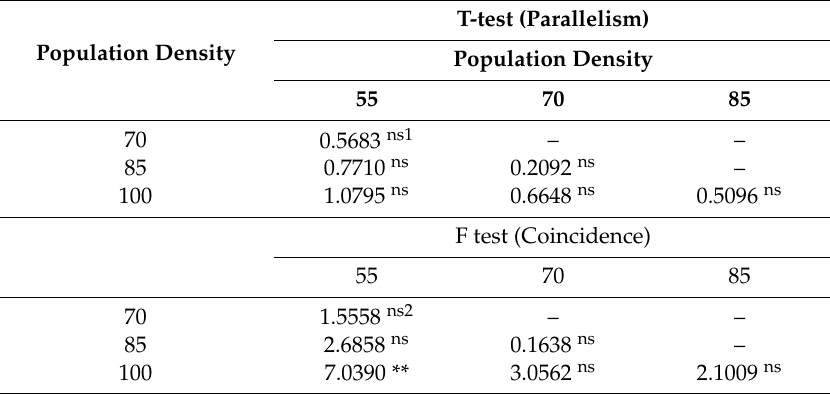
Table 2. T -test for parallelism and F test for coincidence between the straight lines, from the linearized equations for the photosynthetically active radiation.